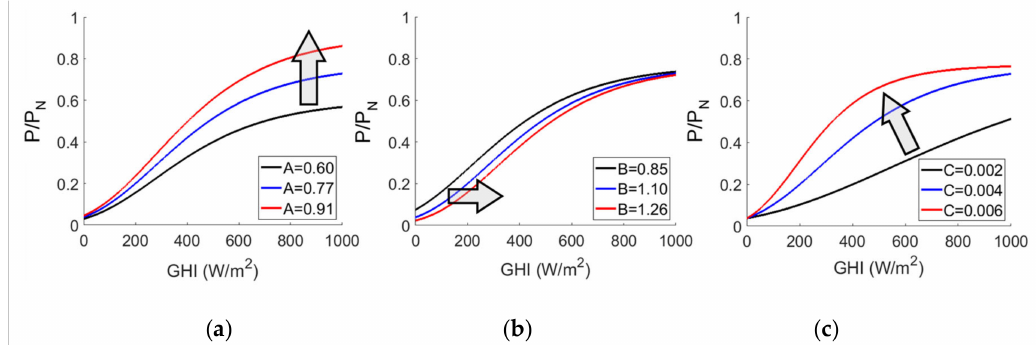
Figure 3. E ff ects of the Gompertz model coe ffi cient: ( a ) e ff ect of A ( B = 1.10, C = 4 · 10 − 3 ), ( b ) e ff ect of B ( A = 0.77, C = 4 · 10 − 3 ), and ( c ) e ff ect of C ( A = 0.77, B =